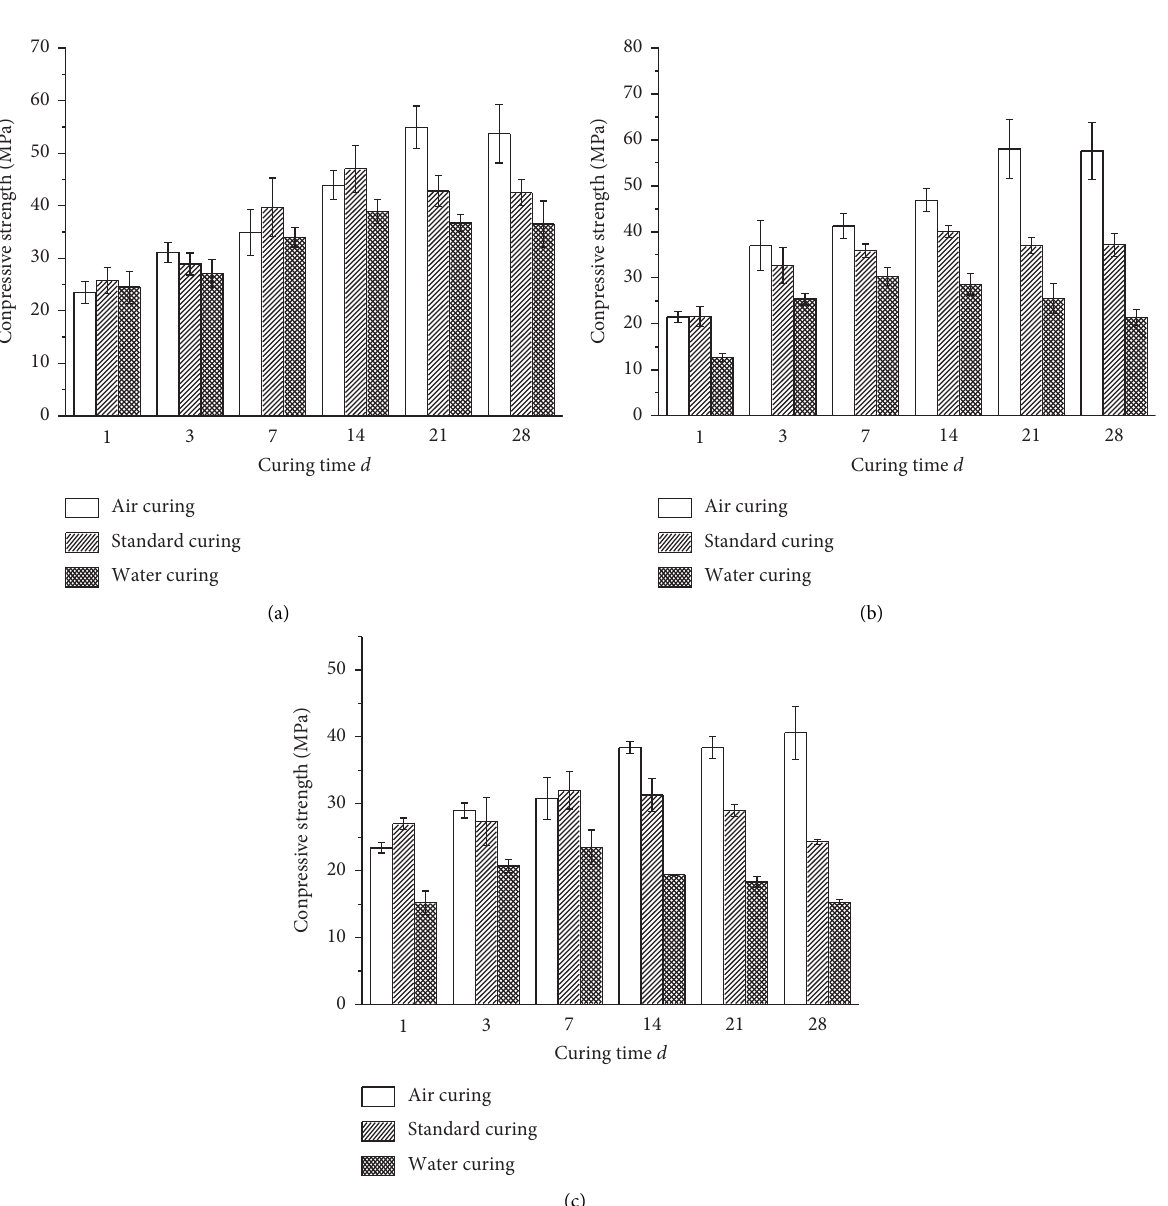
Figure 4: Compressive strength of MPC under various curing conditions after curing at various ratios. (a) M / P � 3:1, (b) M / P � 4:1, and (c) M / P � 5